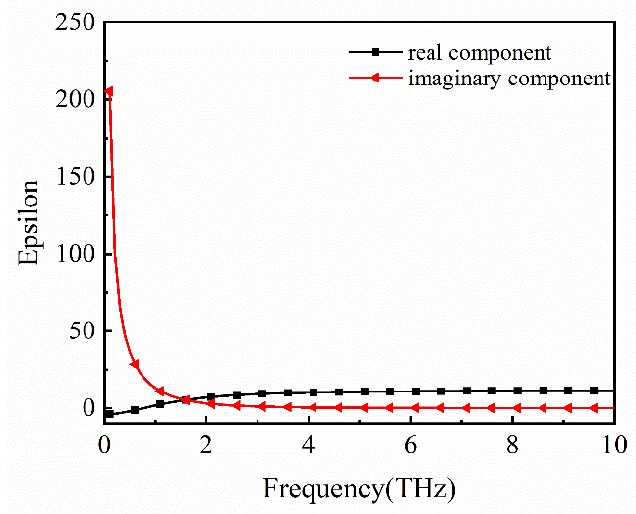
Figure 2. Dielectric property of the p-type doped silicon in THz band. It is described by the Drude model [14] as ε = ε ∞ − ω p , where ε ∞ = 11.7 is the constant permittivity at the infinite frequency, plasma frequency ω p and collision frequency γ are set to 2 π × 5.22 THz and 2 π × 1.32 THz, the corresponding carrier concentration and electron mobility are 8.8 × 10 16 cm −3 and 814.3 cm 2 V −1 s −1 , respectively.